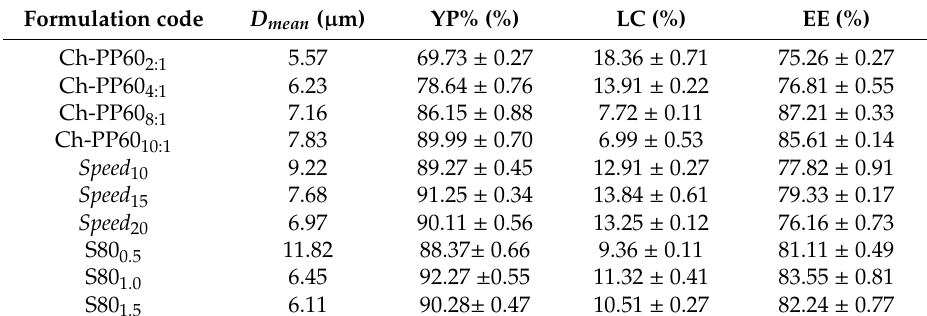
Table 2. Particle size, percentage yield, percent drug content, and entrapment e ffi ciency of uncoated and Eudragit coated chitosan microspheres. The results were subjected to one-way ANOVA (Tukeys Test. Data are presented as mean ± SD (standard deviation); n =